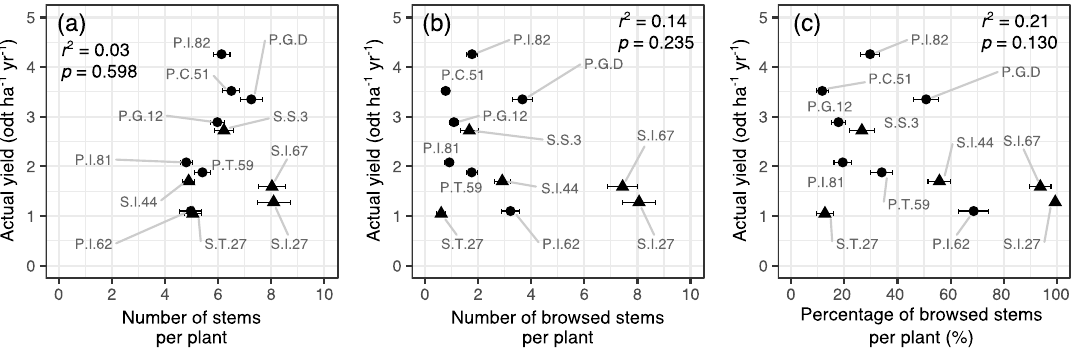
Figure 3. Relationships of the means of number of stems per plant ( a ), number of browsed stems per plant ( b ), and percentage of browsed stems per plant ( c ) to actual willow yield across 12 willow clones. Clone names, coefficients of determination ( r 2 ), and level of significance ( p ) of the standardized major axis regression are shown in each panel. Circles represent Salix pet-susu clones and triangles S. sachalinensis clones; odt, oven dry ton. Error bars represent standard errors of the mean ( n = 34 – 108).